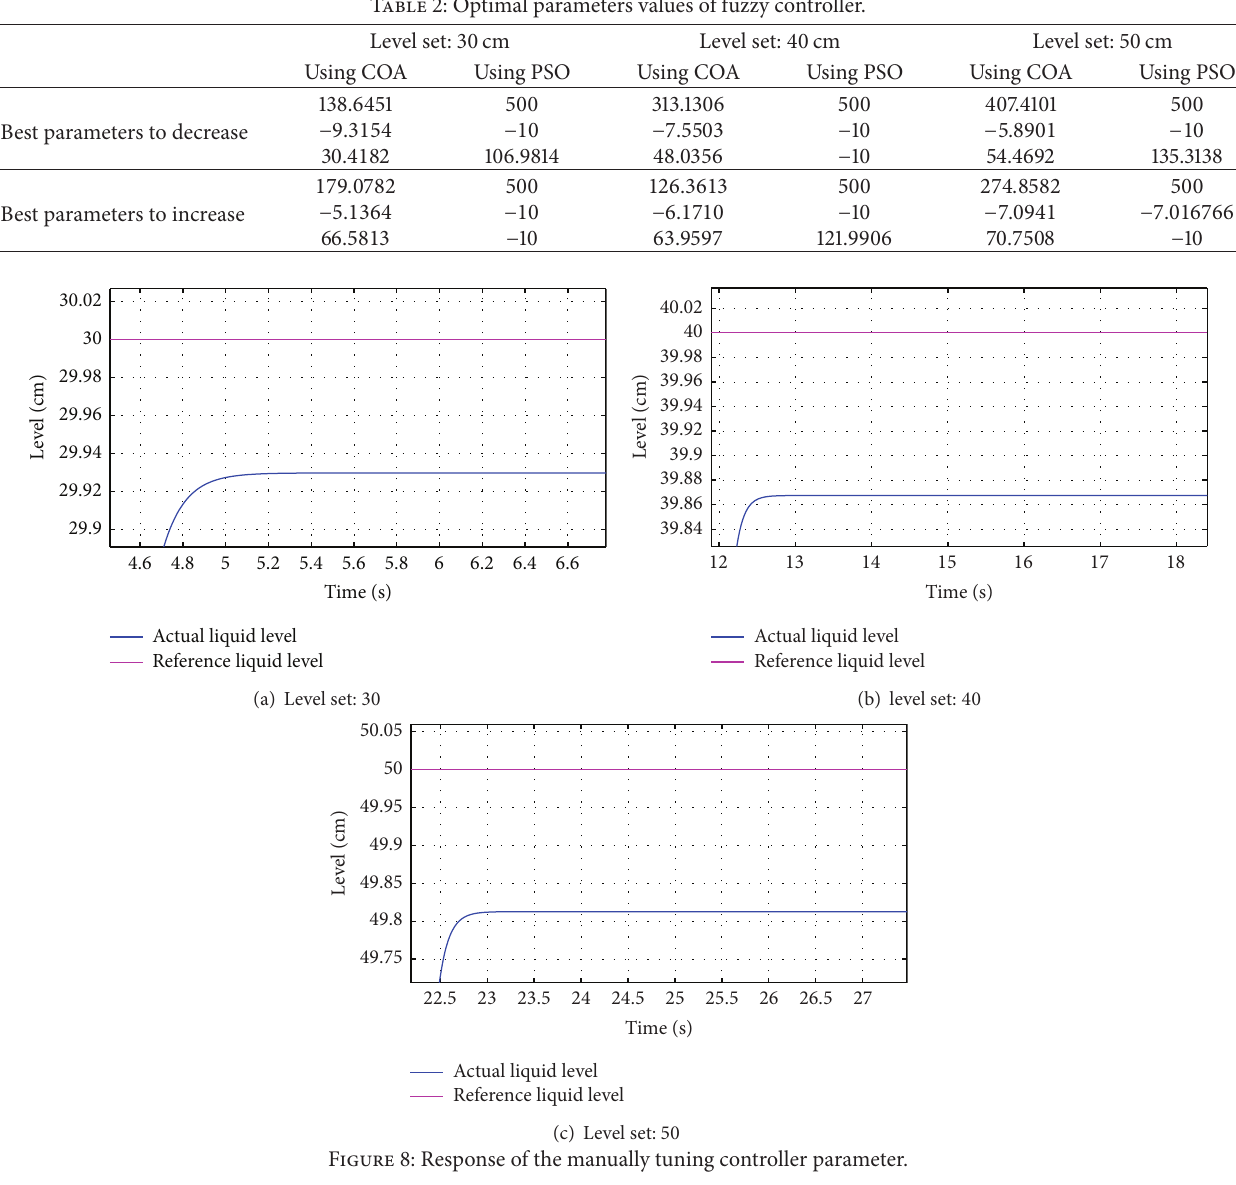
Table 2: Optimal parameters values of fuzzy controller.